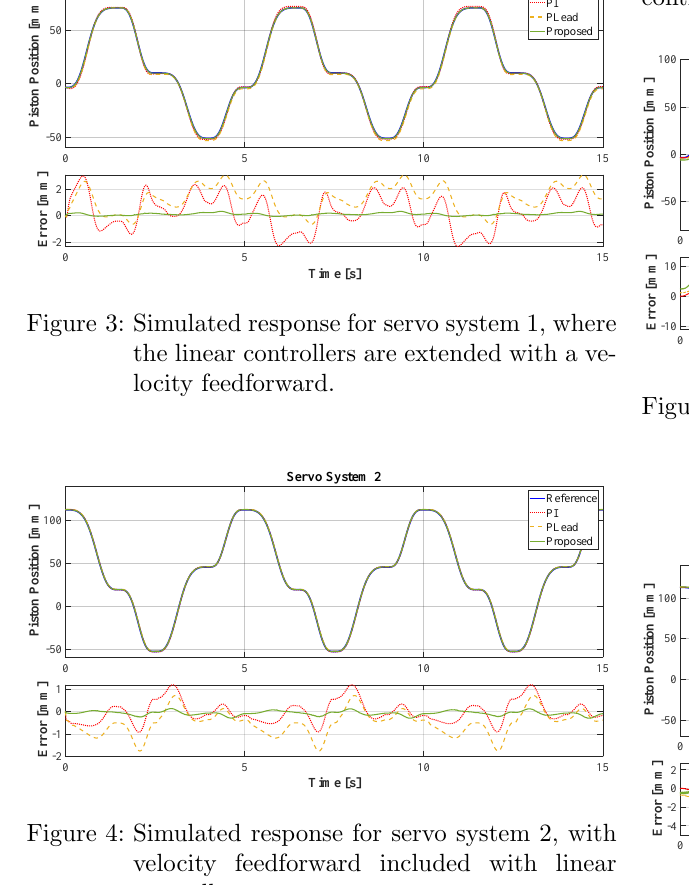
Figure 6: Tracking performance comparison of the pro- posed and reference controllers for servo sys- tem